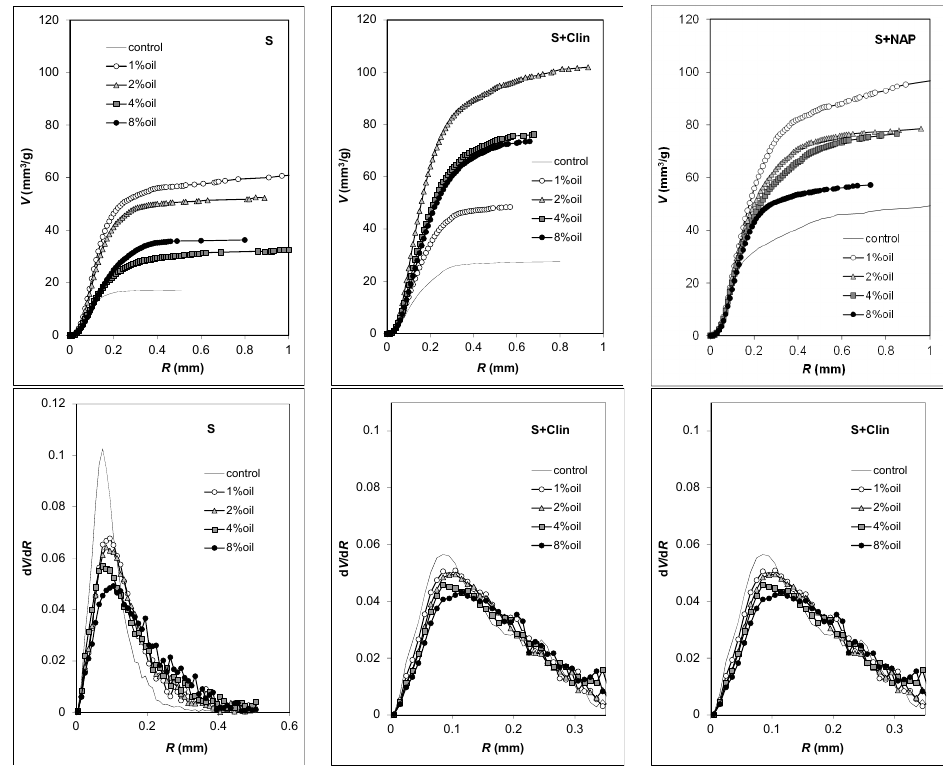
Figure 5. Pore volume vs. pore radius dependencies ( up ) and normalized pore size distribution functions ( down ) derived from microtomography scans. Average results from the experimental replicates are plotted.